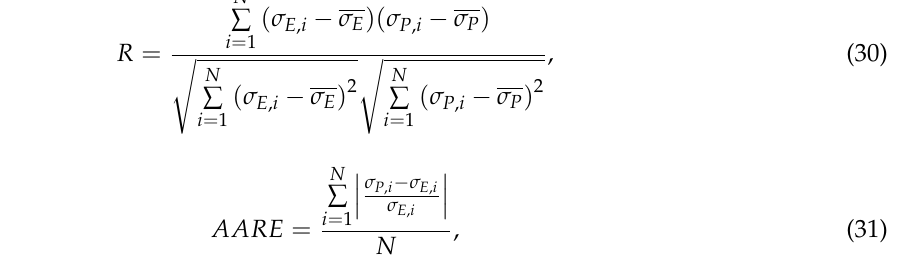
Figure 14. The relationship between